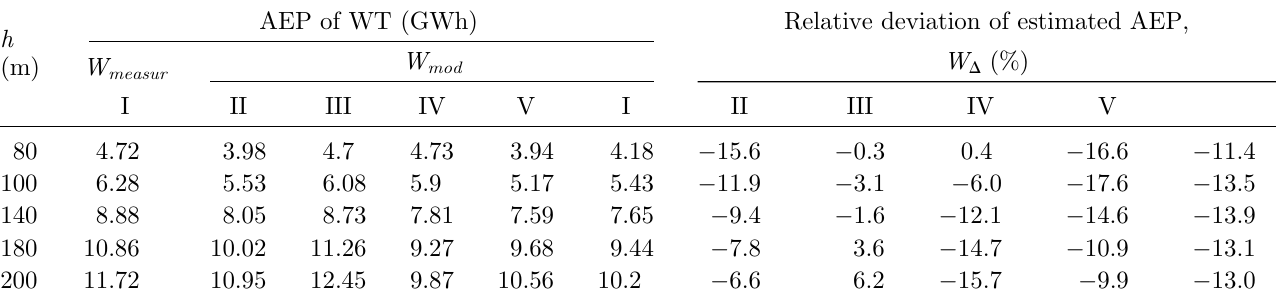
Table 1. Results of AEP calculation for a WT type E82 obtained using models: I (Weibull), II ( V IV (Weibull), V (Weibull) and based on the wind speed measurements at heights 80, 100, 140, 180 and 200